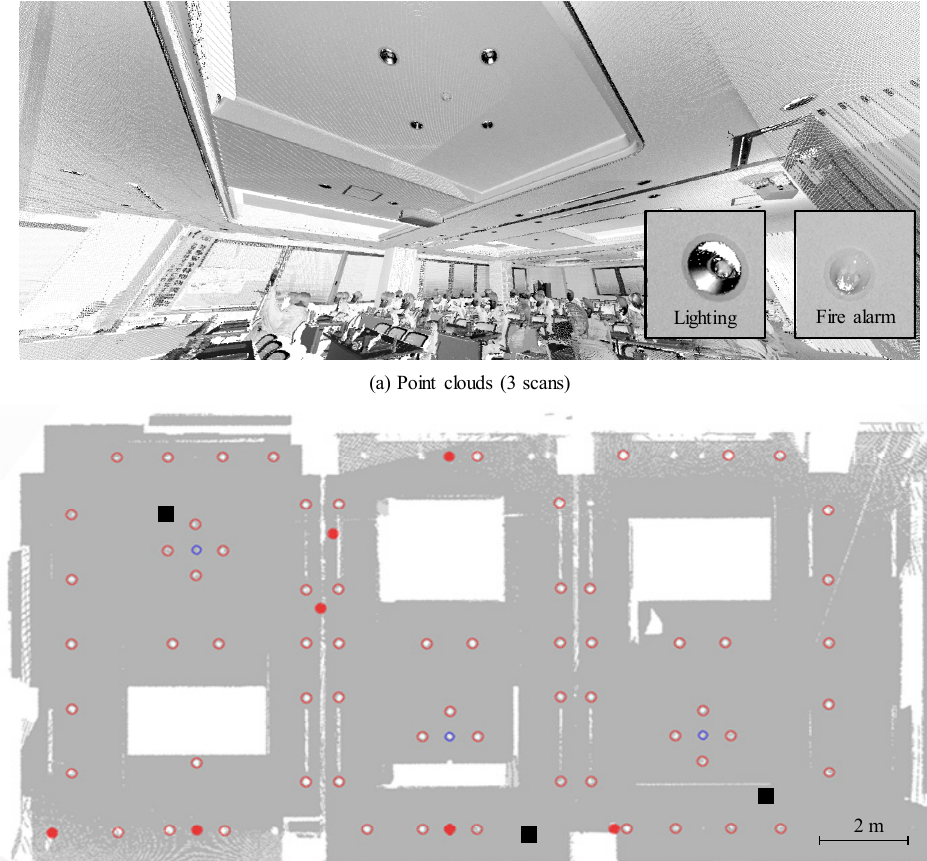
Figure 6. Results of lighting and fire alarm